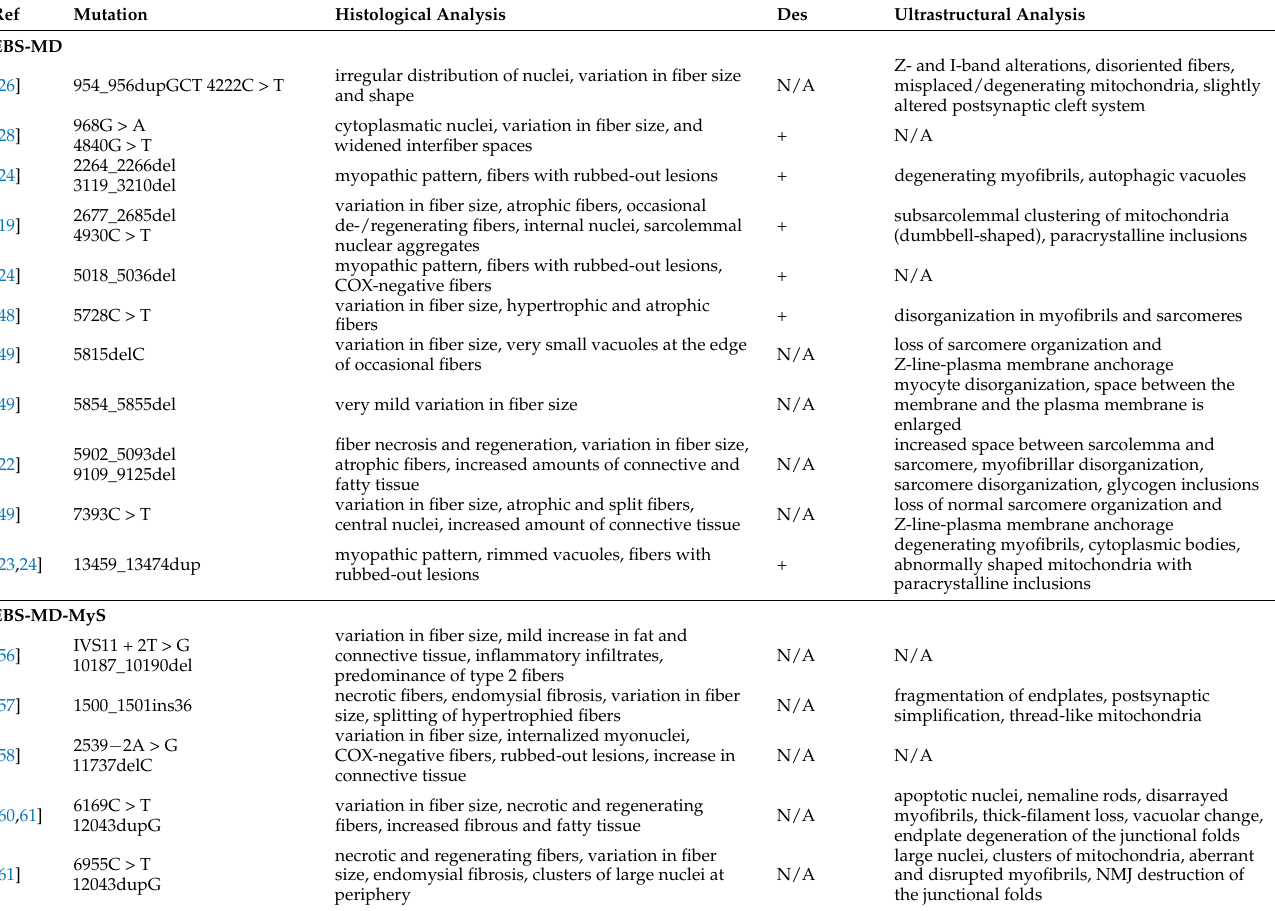
Table 2. Myopathological features of plectinopathy